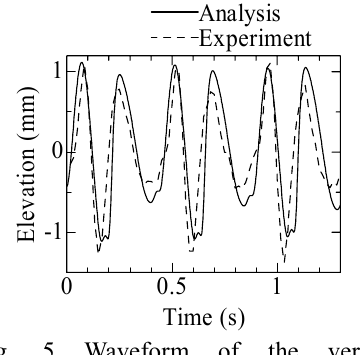
Fig. 5 Waveform of the vertical displacement of the center of interface, indicating higher harmonics superposed on the fundamental